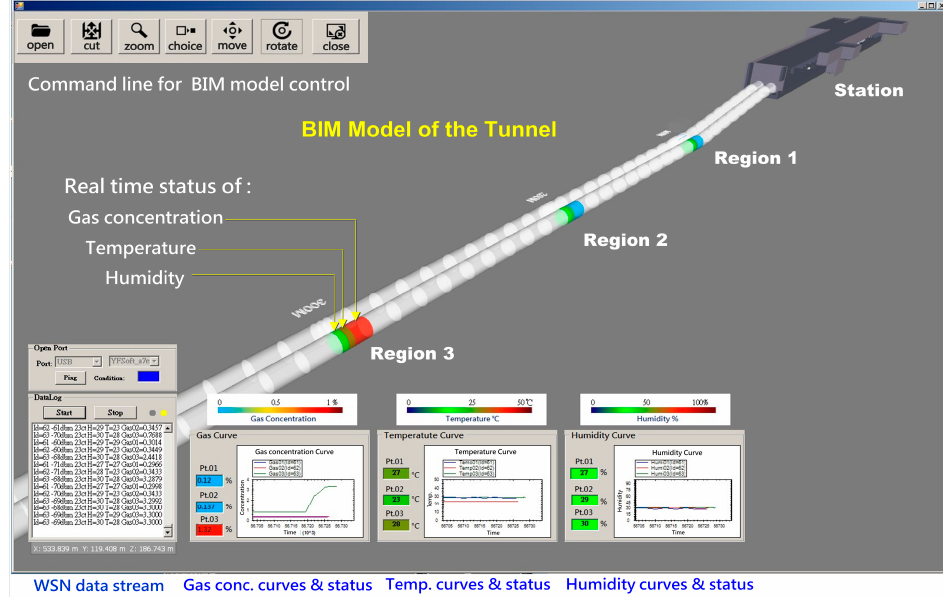
Figure 17. The screenshot of the WSN-BIM safety management system (test in tunnel). (Abnormal gas concentration was detected at region 3 and alerted by red color).